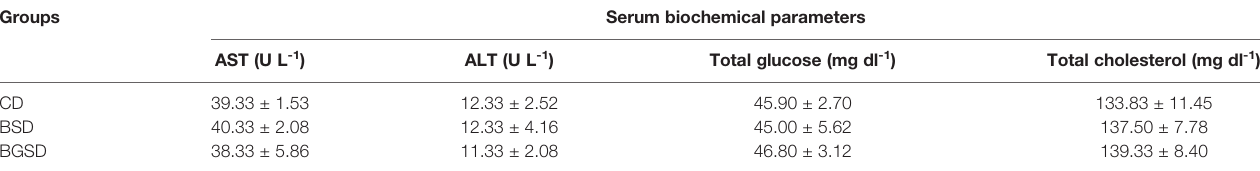
TABLE 4 | Biochemical parameters of red sea bream fed with the experimental diets.